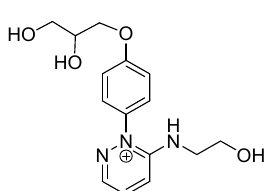
Figure 11. The aromatic region of 1 H NMR spectra of compound 2 ( A ), d 1RR ( B ), compound 1 ( C ). Full circles show the proton on phenyl ring in all species, whereas, the triangles in ( A , B ) indicate the proton resonances attributable to the hydrogen on pyrrole ring and the triangles in ( C ) the pattern of new proton signals in compound 1 .